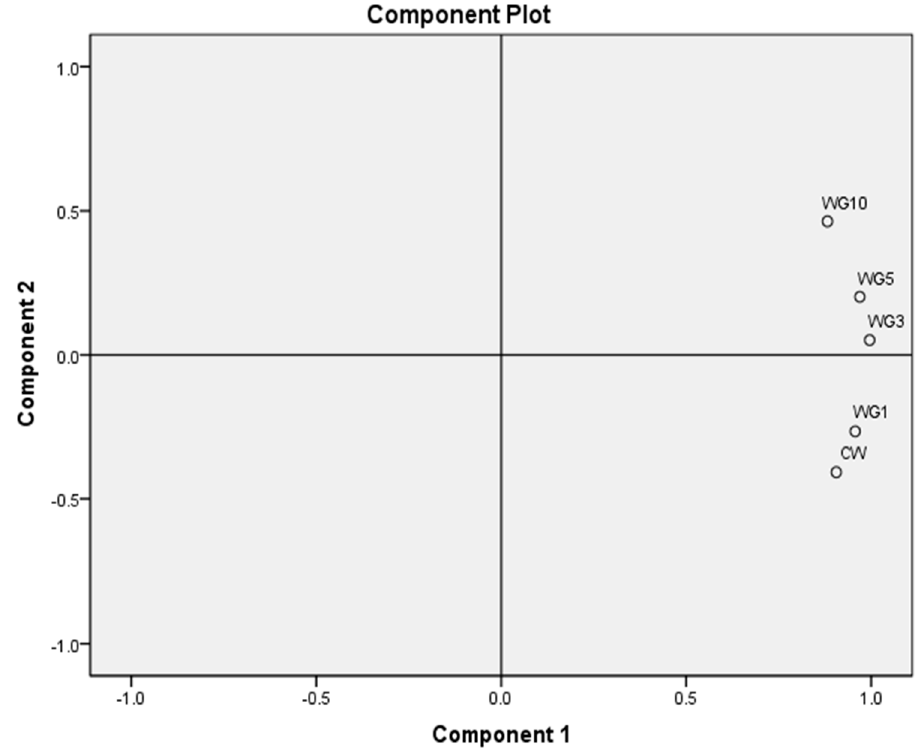
245 246 sensory properties) in the waffle samples.